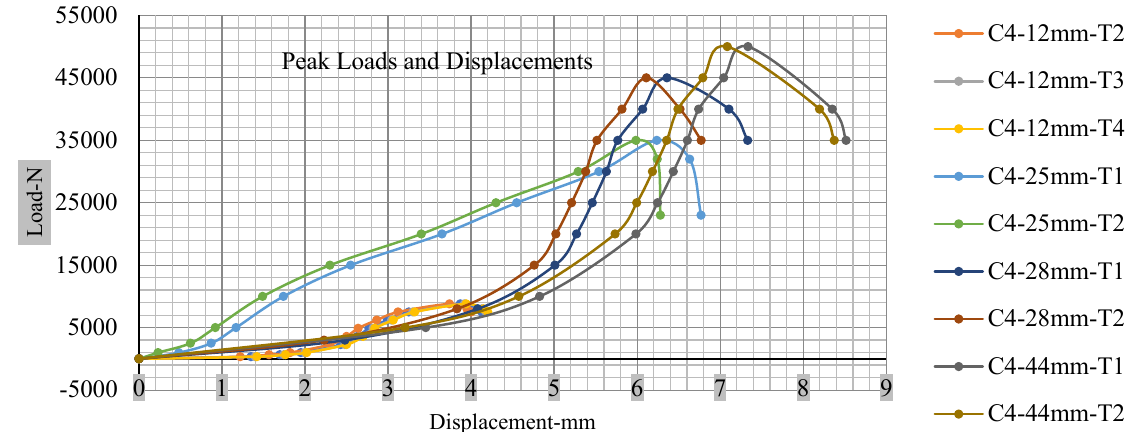
Figure 21. Cell 4 peak loads and displacements.